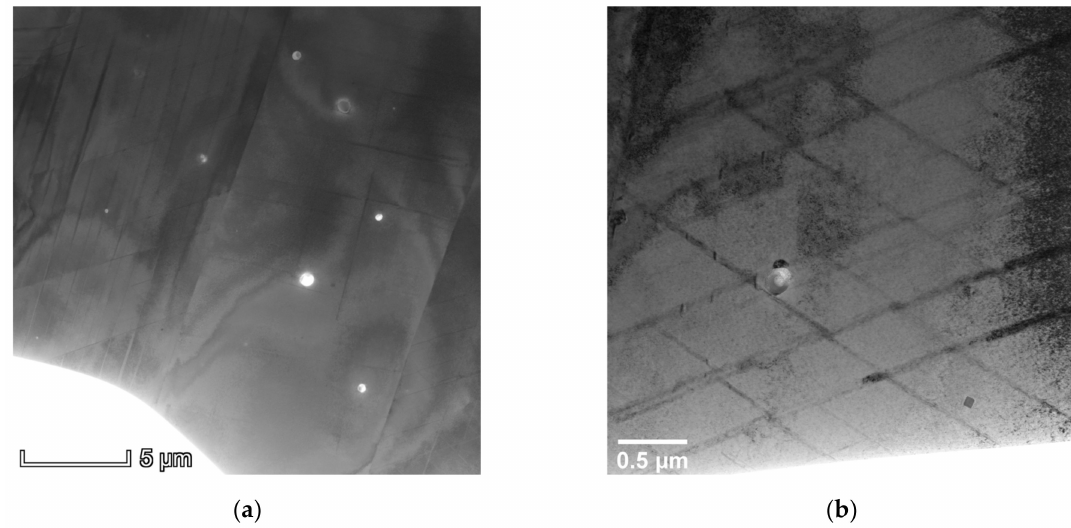
Figure 18. ( a ) Low magnification inverse HAADF image; ( b ) BF TEM image of the as-irradiated 100 dpa